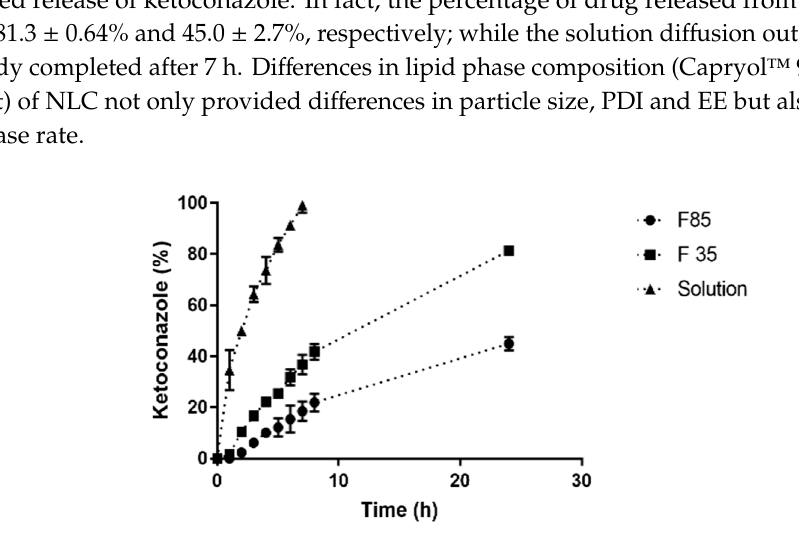
Figure 6. The release profile of ketoconazole from F 30 and F 85 using the dialysis bag method ( n = 3, ± SD).